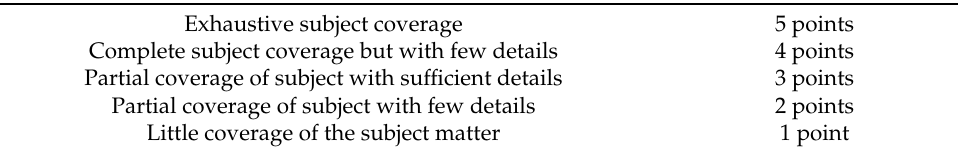
Table 3. Exhaustivity score